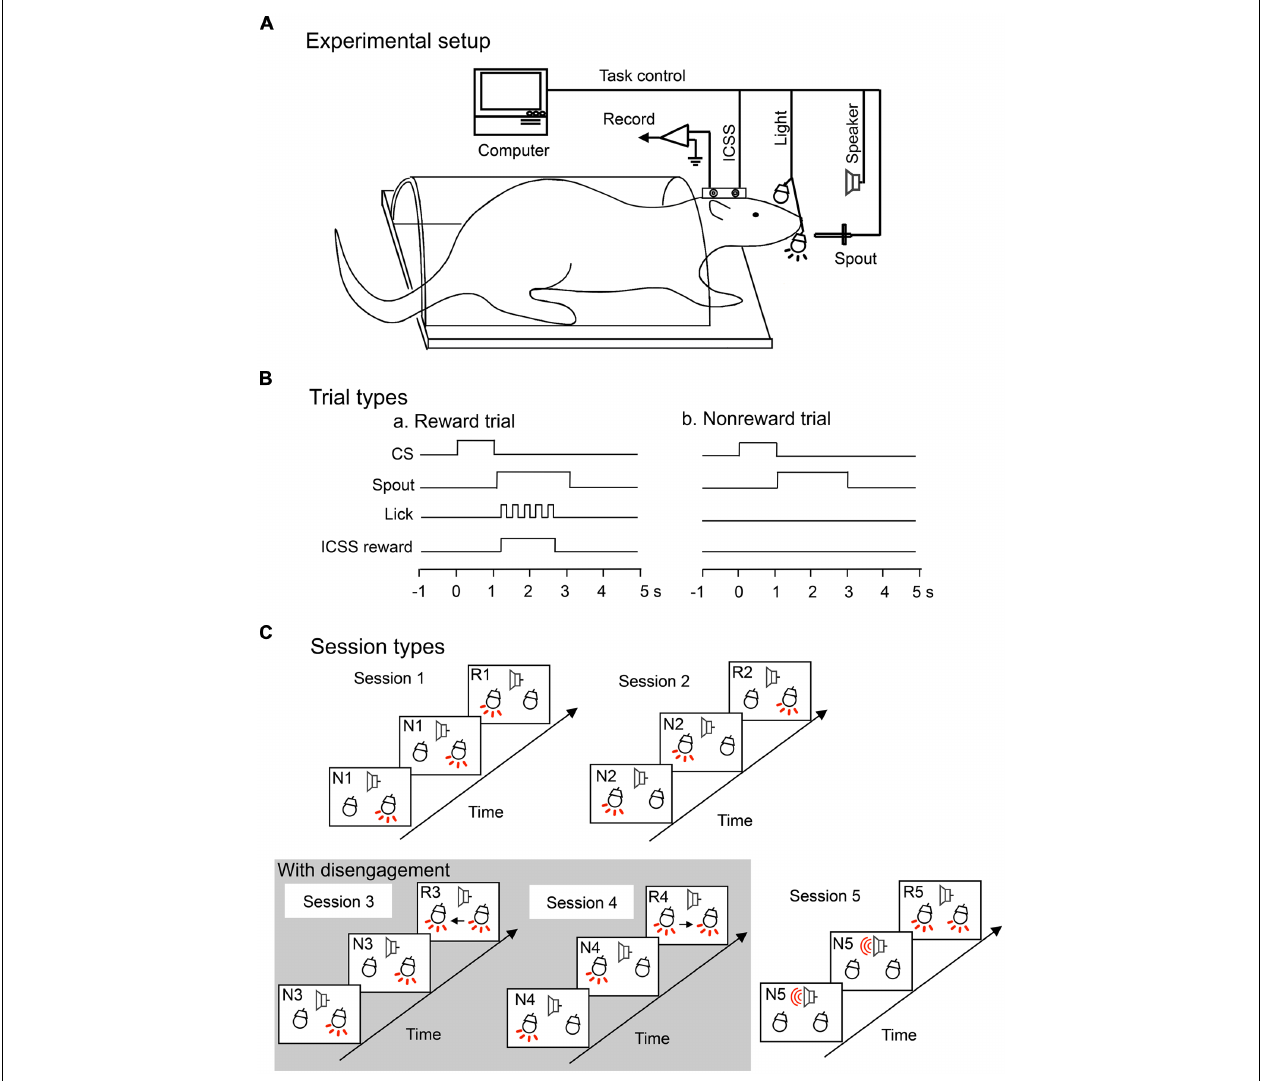
light (frequent stimulus) was sequentially presented, and when the right light (infrequent stimulus) appeared, the rat could acquire reward if it licked the spout. In sessions 3 and 4, right and left lights (frequent stimuli) were similarly presented, respectively. However, the infrequent stimuli appeared with the frequent stimuli.Therefore, in sessions 3 and 4, the rat must disengage attention from the frequent stimulus. Arrows show attention disengagement and subsequent direction of attentional shift. Lights and speaker with the red-colored lines indicate that these apparatuses are turned on. In session 5, tone (frequent stimulus) was sequentially presented, and when both right and left lights (infrequent stimuli) were simultaneously presented, the rat could acquire reward if it licked the spout. Note that the infrequent stimuli in session 5 were the same as those in sessions 3 and 4, but attentional disengagement was not required in session 5. R1–R5, reward trials in sessions 1–5; N1–N5, non-reward trials in sessions